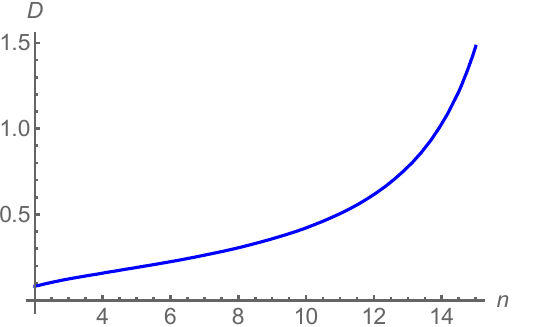
Figure 1. The relative difference D = ( σ − σ 2 ) / σ 2 in the cross-sections of the resonant charge exchange for the usual hydrogen atoms and the second flavor of hydrogen atoms (SFHA) versus the principal quantum number n for the quantum number q = n − 1 and the relative velocity of the colliding particles v = 0.1.